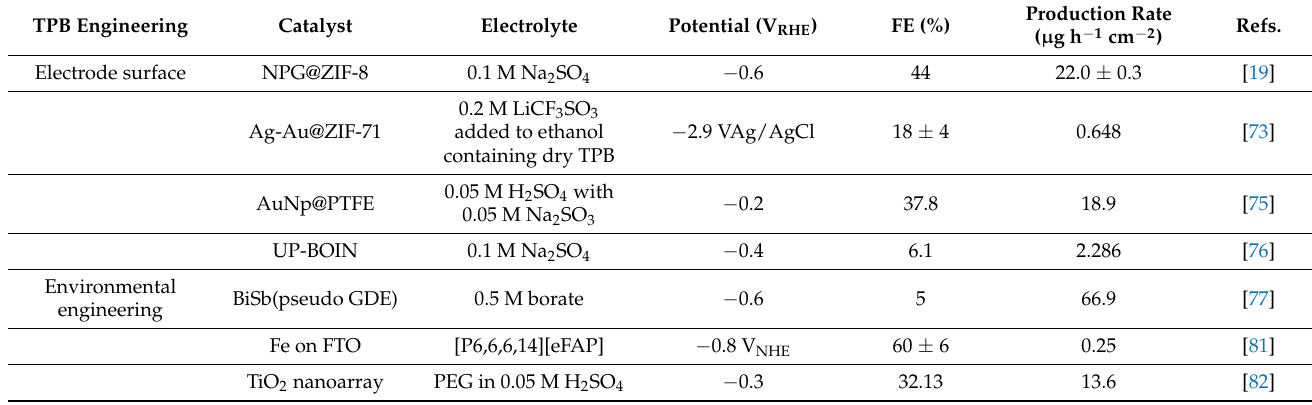
Table 2. A brief summary of experimental studies on ENRR using various TPB engineering